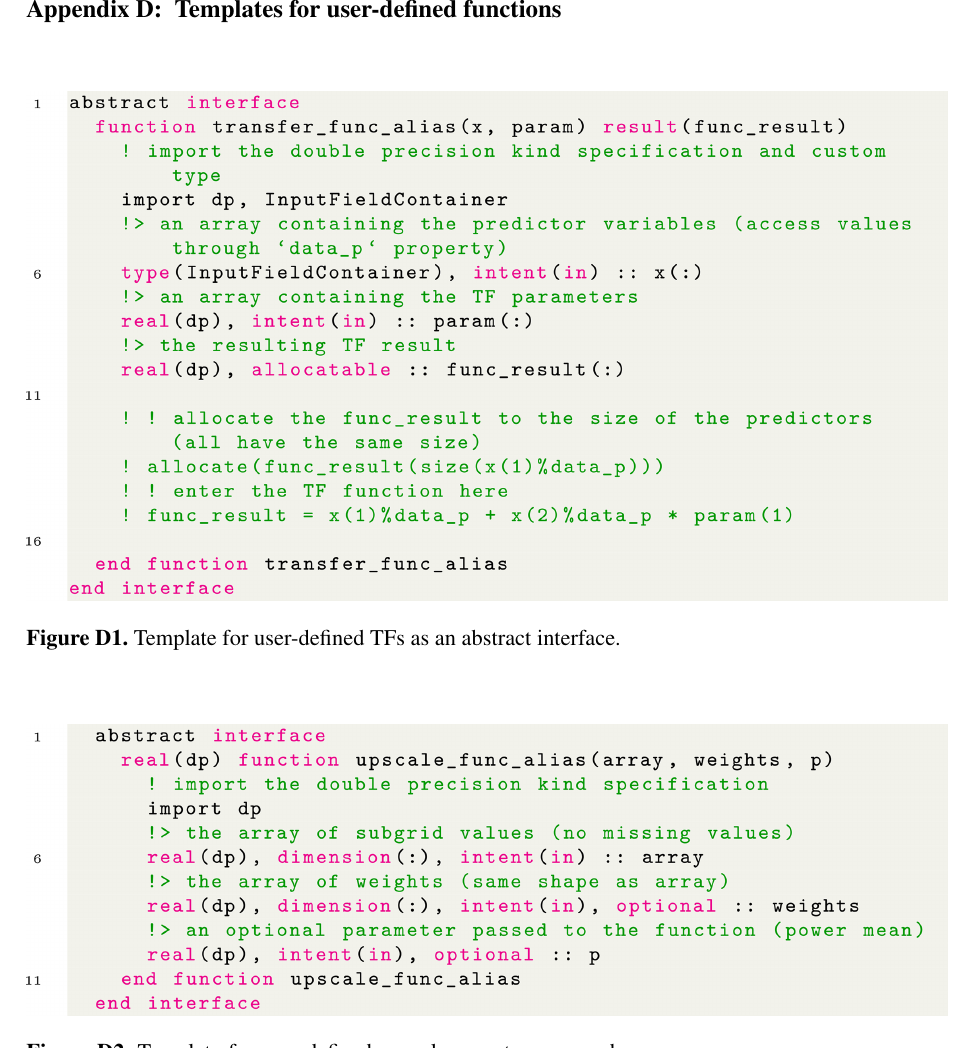
Figure D2. Template for user-defined upscale operators as an ab- stract